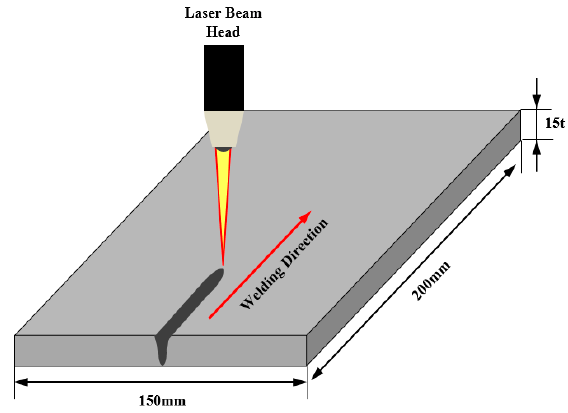
Figure 2. A schematic diagram for the fiber laser welding process. Table 1. Mechanical properties of base metal.